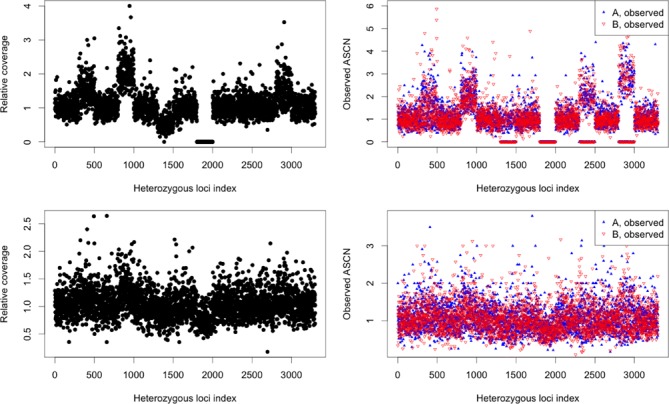
The relative coverage (left panel) and observed allele-specific copy number (right panel) of simulation data with 100% tumor purity (first row) and 25% tumor purity (second row).